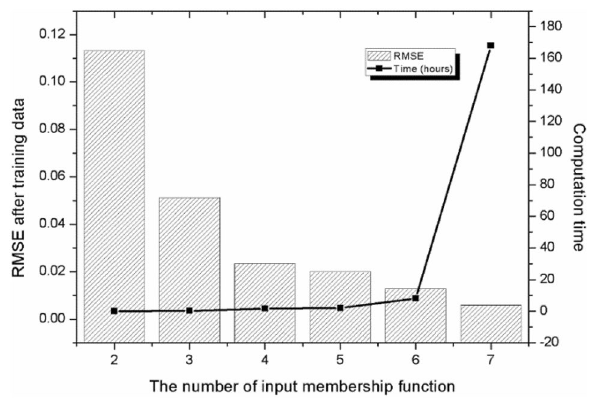
Figure 7. Root mean square error (RMSE) and computation time of the ANFIS model with respect to the number of input membership